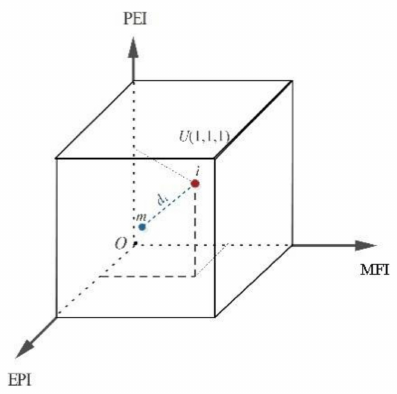
Figure 2. Concept map of SDM (As an example of measuring the